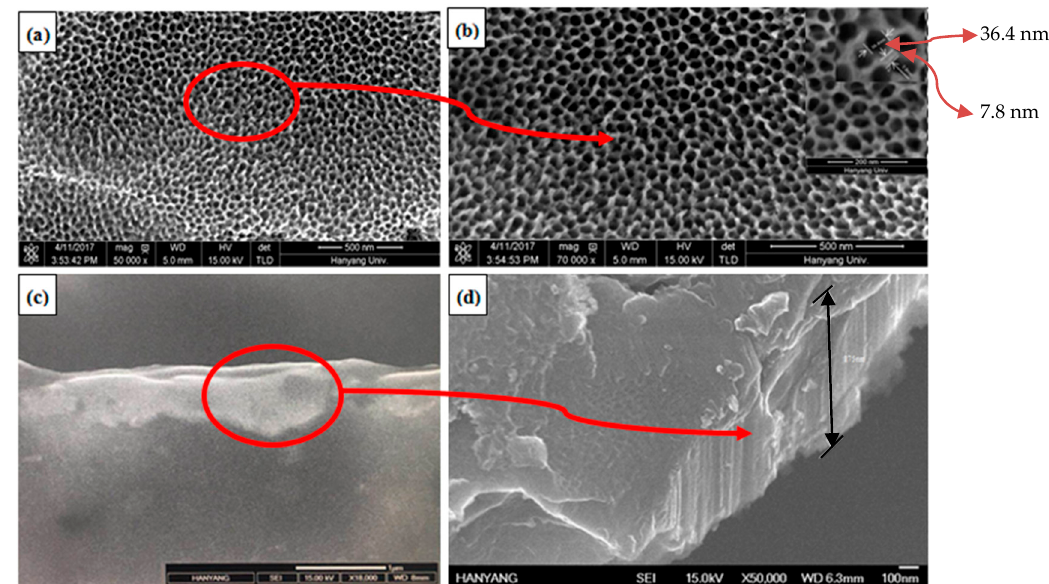
Figure 3. ( a , c ) Low- and ( b , d ) high-magnification field emission scanning electron microscope (FESEM) images of the anodized substrate for 2 h obtained from 0.4 M NH 4 F and 0.2 M H 3 PO 4 electrolyte at 10 V before thermal annealing: ( a , b ) top-views and ( c , d ) cross-sectional views.